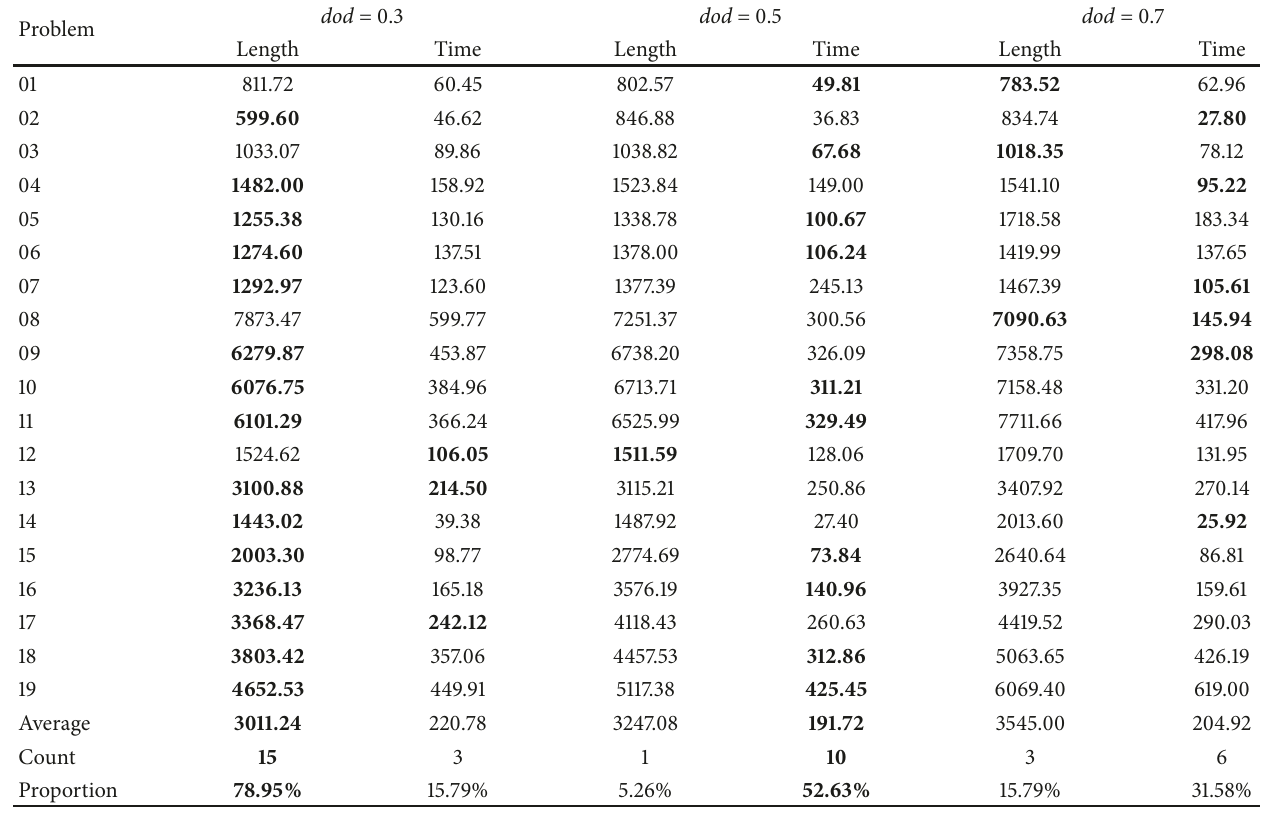
Table 5: Comparisons based on different degrees of dynamism.